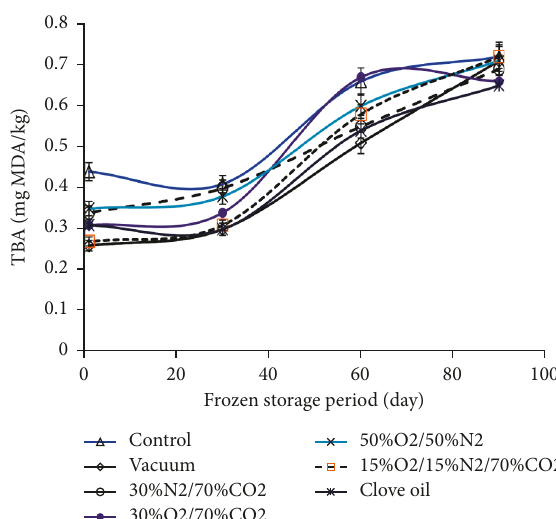
Figure 3: TBA vs. FSP at different MAP treatments of CTMP.